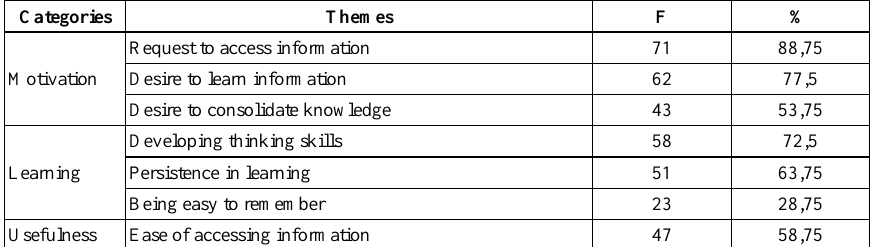
Table 4. Students' opinions on the advantages of mobile learning